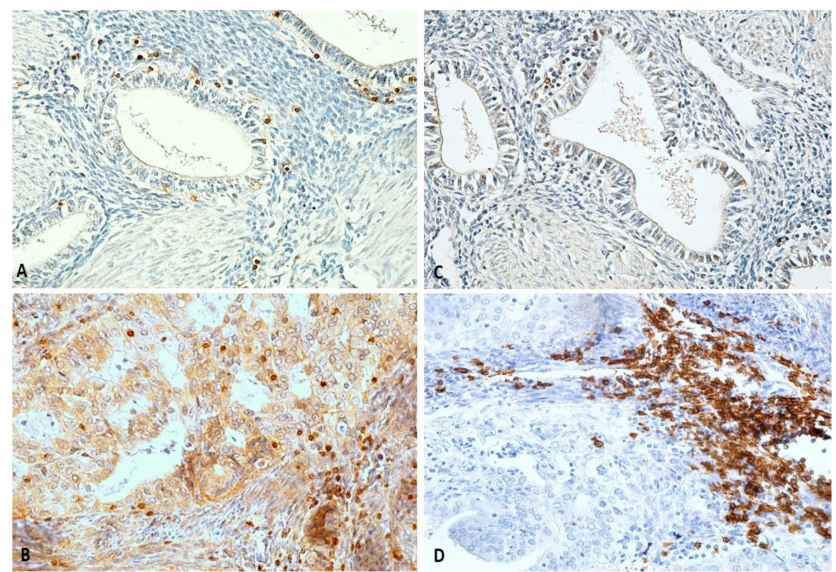
Figure 7. ( A – D )—Presence of T lymphocytes in endometriotic foci with or without atypia. ( A ) Ade- nomyosis. Immunolabeled T lymphocytes (brown marking) present in the periglandular stroma; ( B ) hyperplastic transformed adenomyosis, with atypical cellularity. Numerically enlarged, immuno- labeled (brown marking) T lymphocytes are present in the periglandular stroma—immunostaining with anti-CD3 antibody, [ × 200]; ( C ) endometriosis of the abdominal wall. Immunolabeled B lym- phocytes (brown marking) are present in the periglandular stroma; ( D ) hyperplastic transformed adenomyosis, with atypical cellularity. Immunolabeled B lymphocytes (brown marking) are observed in the periglandular stroma. Immunostaining with anti-CD20 antibody, [ × 200]. CD3: Cluster of differentiation 3, CD20: Cluster of differentiation 20.